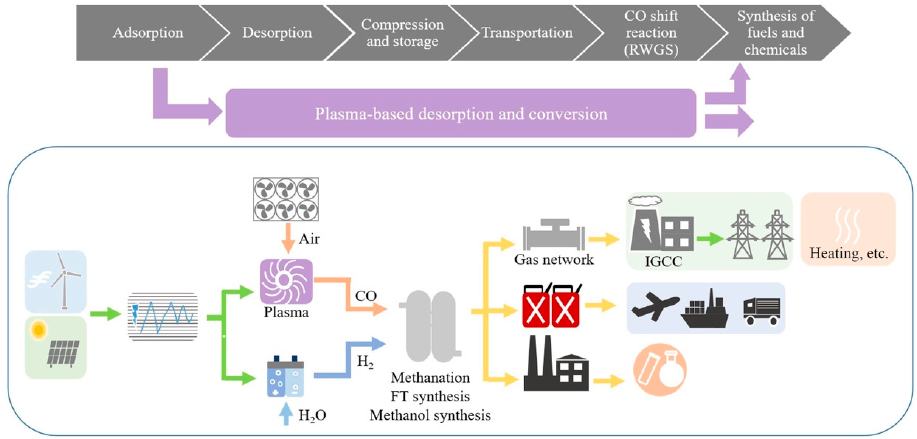
Figure 4. Plasma-based direct air capture of CO 2 for energy storage via syngas production. Repro- duced from reference [64], published under the license CC BY 4.0.